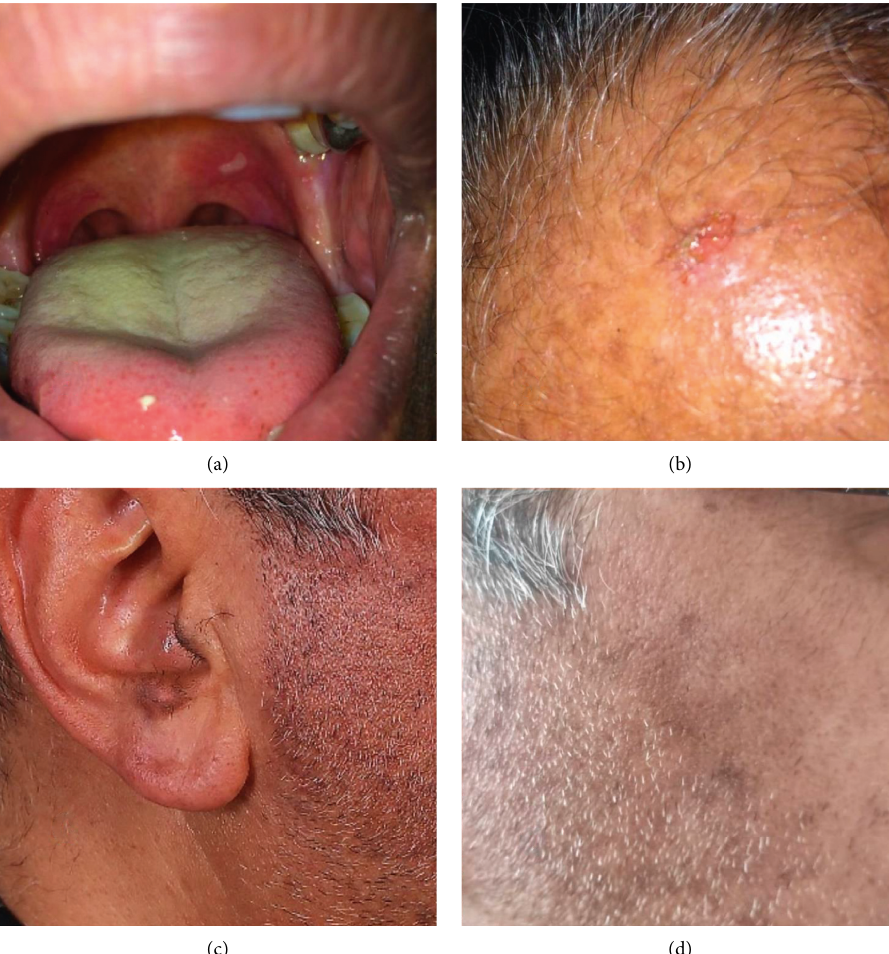
Figure 1: Oral mucosal lesions (a) and scalp erosion (b) due to pemphigus and hyperpigmented macules on ear (c) and cheek (d) due to lichen planus pigmentosus following COVID-19